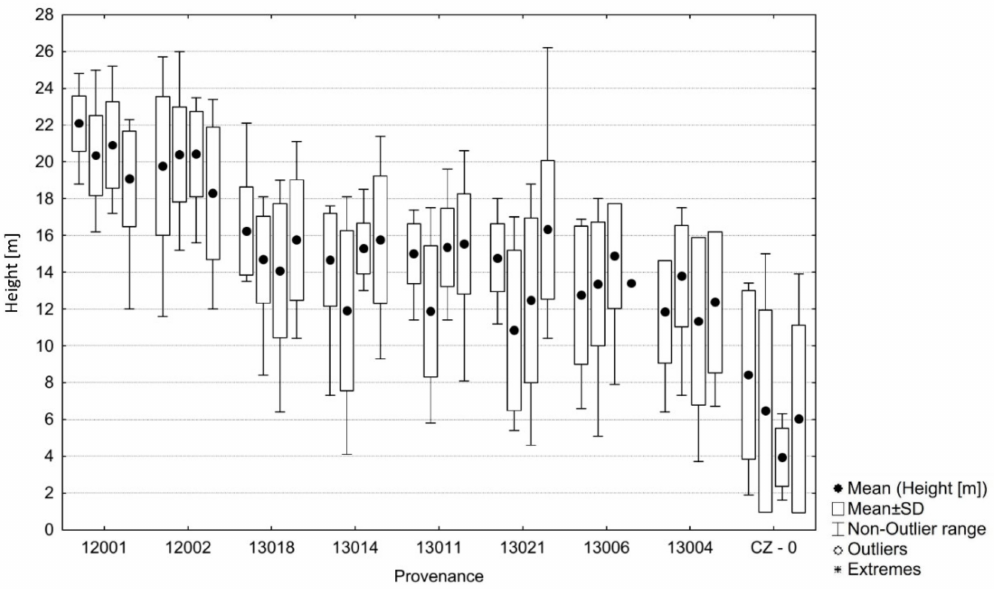
Figure A9. Box plot of height variation statistics by replications and by provenance in the trial Dražiˇcky. The provenances are sorted by groups of mean heights (compare Figure